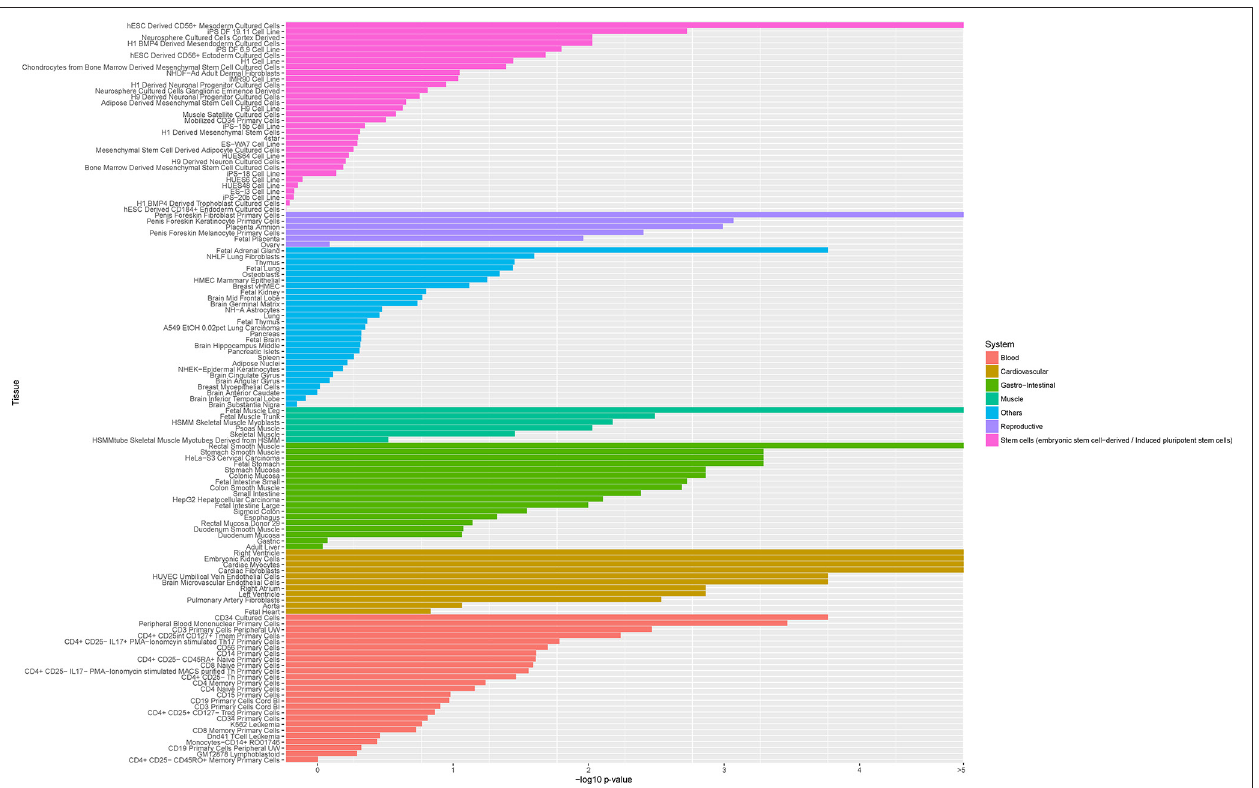
FiGuRe 3 | Ranked tissues after phenotypic cell-type specificity analysis of 905 BP SNPs using 125 H3K4me3 datasets on human tissue ( Supplemental Methods , Table S3